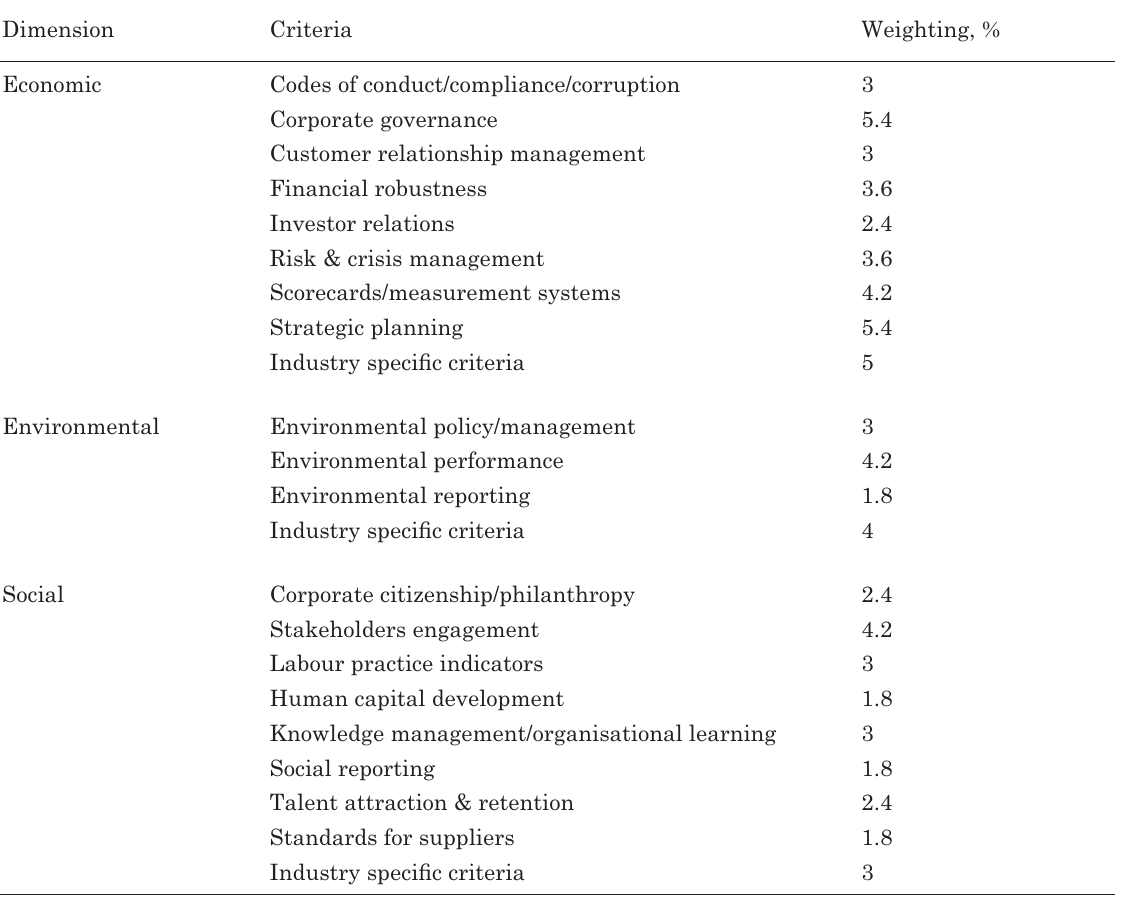
Table 3. Corporate sustainability assessment criteria and weightings (Dalal-Clayton and Sadler, 2004) Dimension